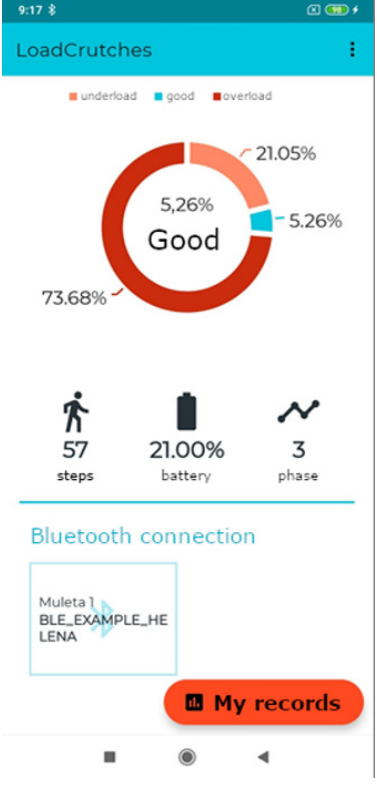
Figure 4. Mobile application overview.